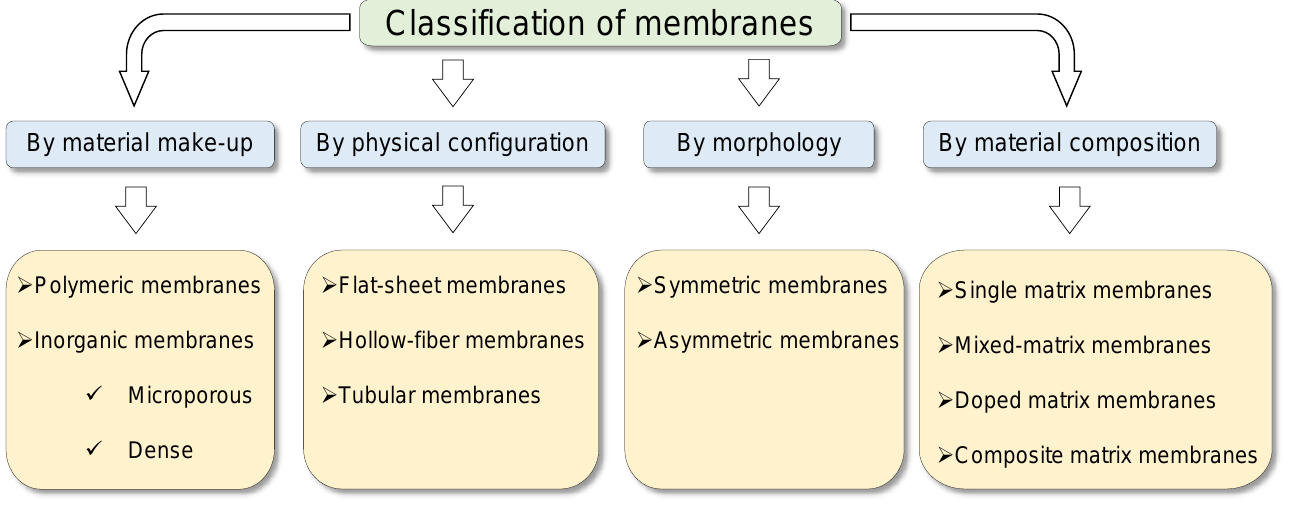
Figure 1. An overview of membrane classification.